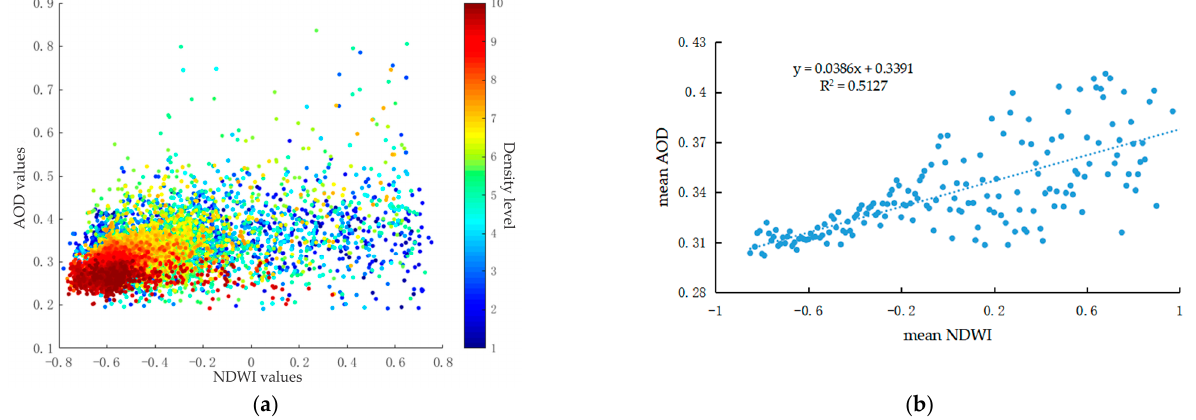
Figure 6. Relationship between AOD (Aerosol Optical Depth) and NDWI (Normalized Difference Water Index) values: ( a ) scatterplots and ( b ) regression equation.